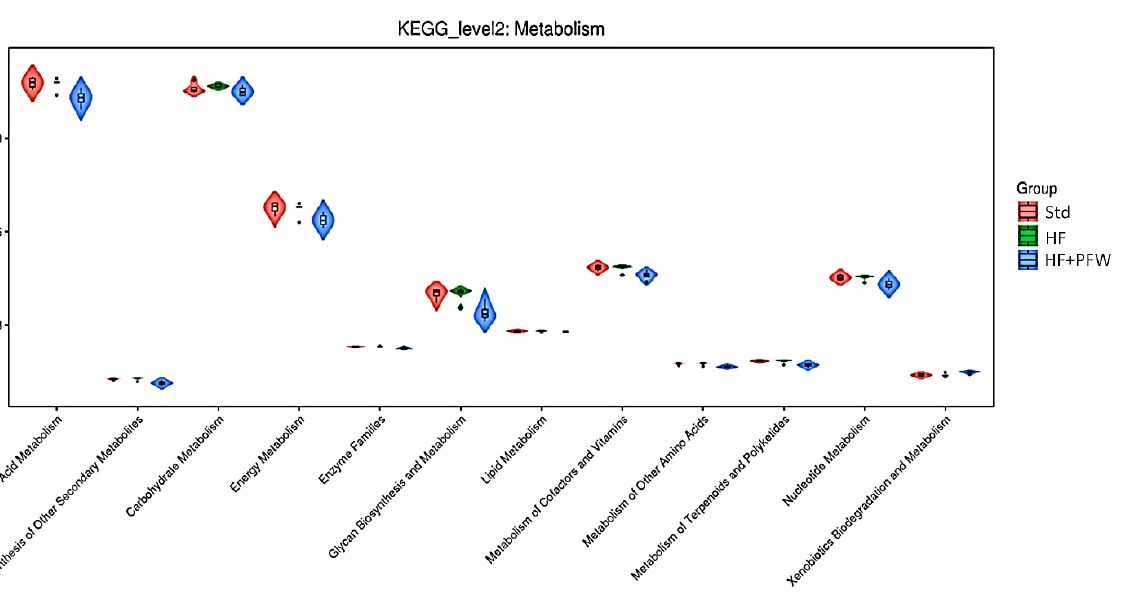
Figure 9. Violin image of KEGG function prediction based on 16S rRNA gene. Comparison of the gut microbiota function prediction among different groups. The function of the gut microbiota affecting metabolism was predicted using KEGG level 2. Group Std, standard diet; group HF, high-fat diet; group HF+PFW, high-fat diet plus PFW treatment.